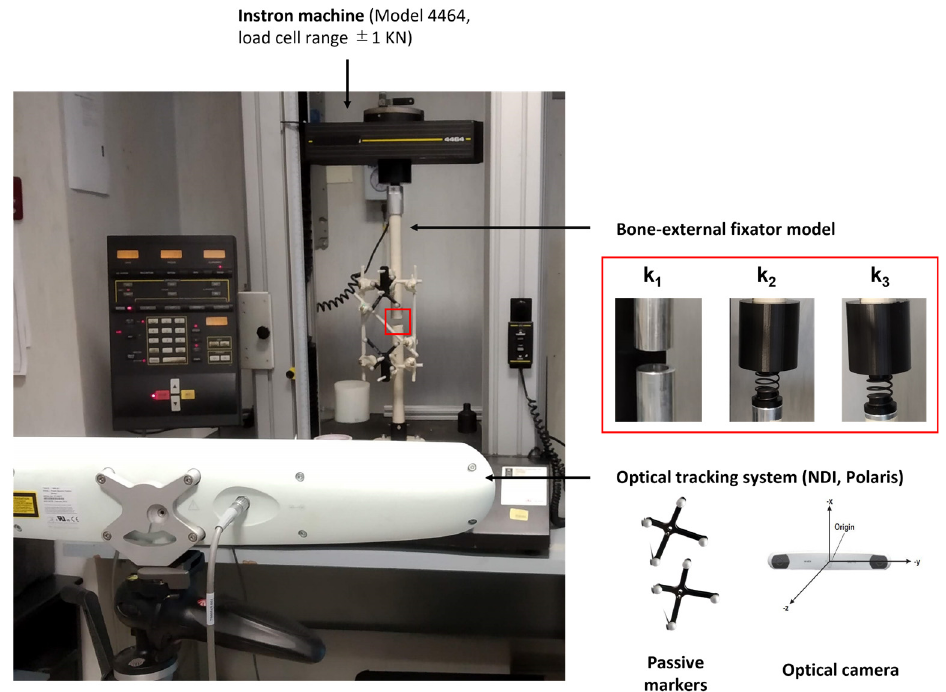
Figure 3. Experimental setup for FEM model validation .